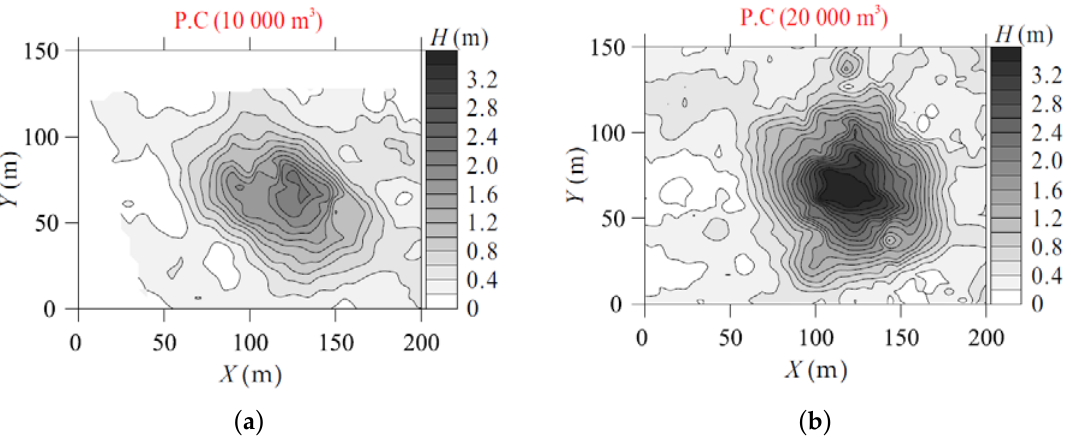
Figure 13. The morphological feature of second placement over the existing mound at P.C, ( a ) 10,000 m 3 ; ( b ) 20,000 m 3 .